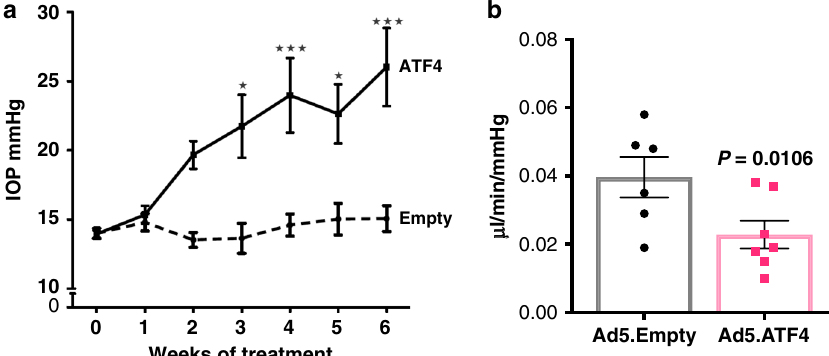
Fig. 2 ATF4 induces ocular hypertension and reduces aqueous humor out fl ow facility in mice. a 3 months old C57BL/6J mice received bilateral intravitreal injections of Ad5.Empty or Ad5.ATF4 (2 × 10 7 pfu/eye). IOPs were monitored using rebound tonometry on conscious mice. ATF4-injected mice showed signi fi cant IOP elevation starting from 3 weeks injections compared to Empty-injected mice ( n = 10 each group, data are presented as mean ± SEM, two-way ANOVA, Bonferroni ’ s multiple comparisons test *P < 0.05, *** P < 0.001). b Conventional out fl ow facility was signi fi cantly reduced in Ad5.ATF4- injected mice (0.022 µ L/min/mmHg; n = 6) compared to Ad5.Empty injected mice (0.042 µ L/min/mmHg; n = 6) (data are presented as mean ± SEM, two-tailed unpaired t